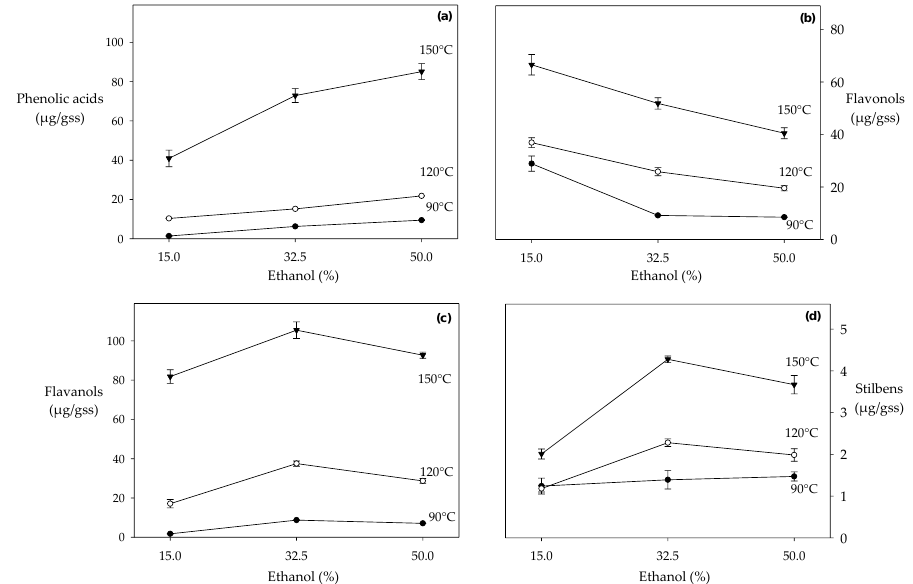
Figure 1. Recovery of polyphenol families in HPLE at different temperatures and ethanol concentrations: ( a ) phenolic acids; ( b ) flavonols; ( c ) flavanols; ( d ) stilbenes (resveratrol).